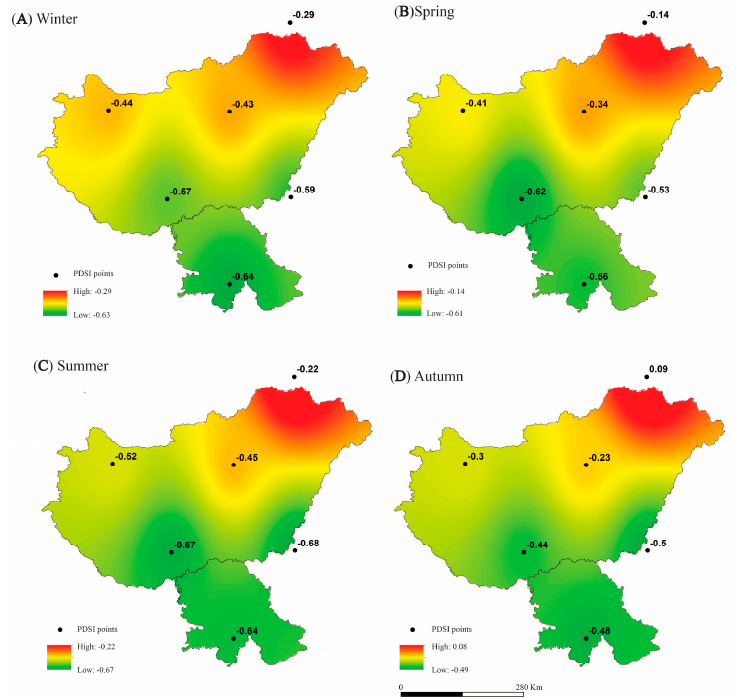
Figure 7. The spatial distribution of the seasonal Palmer Drought Severity Index for Hungary and Vojvodina presented jointly during the period 1920–2014; ( A ) winter, ( B ) spring, ( C ) summer, and ( D ) autumn.